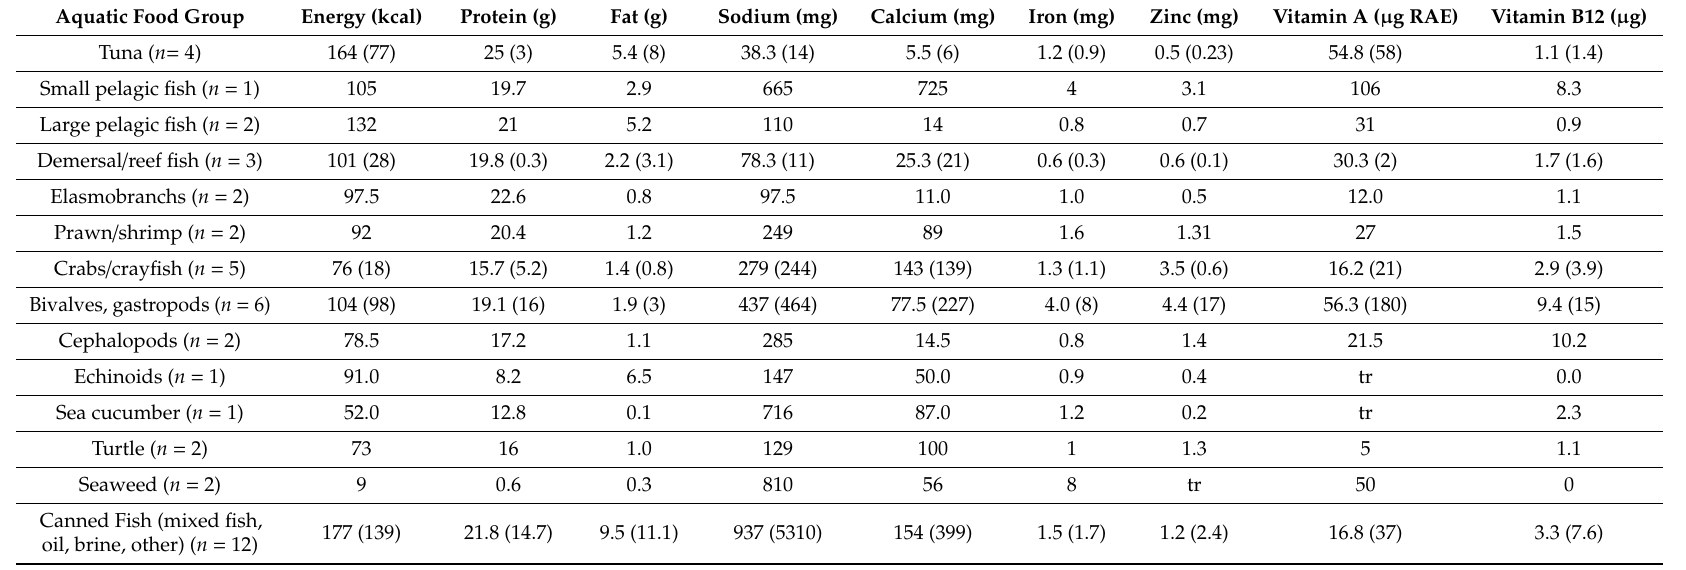
Table 1. Nutritional composition of aggregated aquatic food groups consumed in the Pacific (Nutrient values are based on 100 g edible portions; nutrient composition data adapted from the Pacific Nutrient